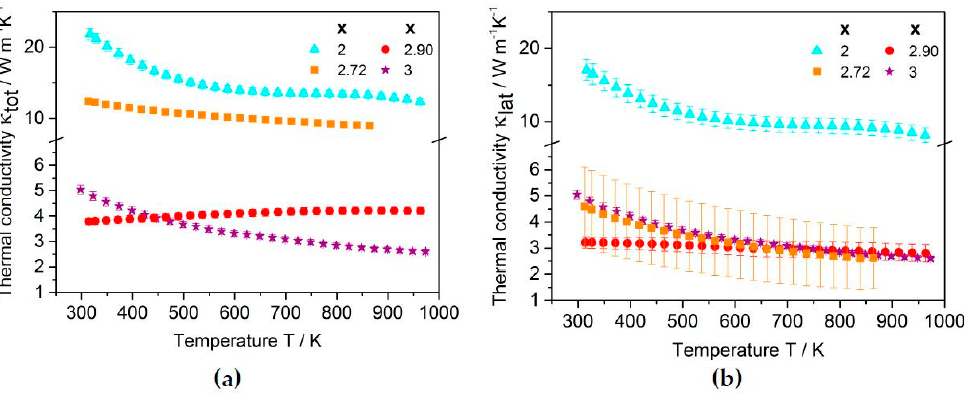
Figure 6. Thermal conductivity of the oxides WO 2 , WO 2.72 , WO 2.90 and WO 3 : ( a ) Total thermal conductivity κ tot . ( b ) Lattice contribution κ lat = κ tot − κ el with κ el from the Wiedemann-Franz law. Mind the different scales of the broken axis.